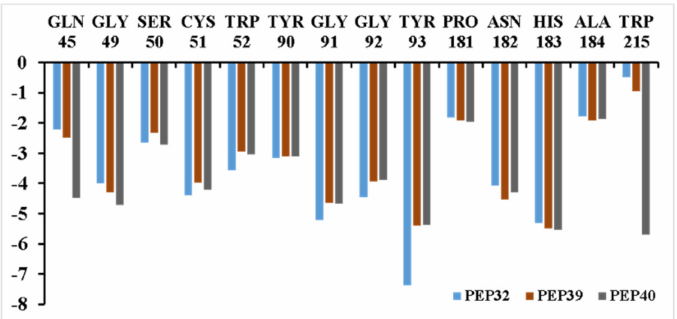
Figure 3. Breakdown of interaction energy (kcal/mol) contribution between PEP32, PEP39, PEP40 and the most interacting residues of the FP3 active